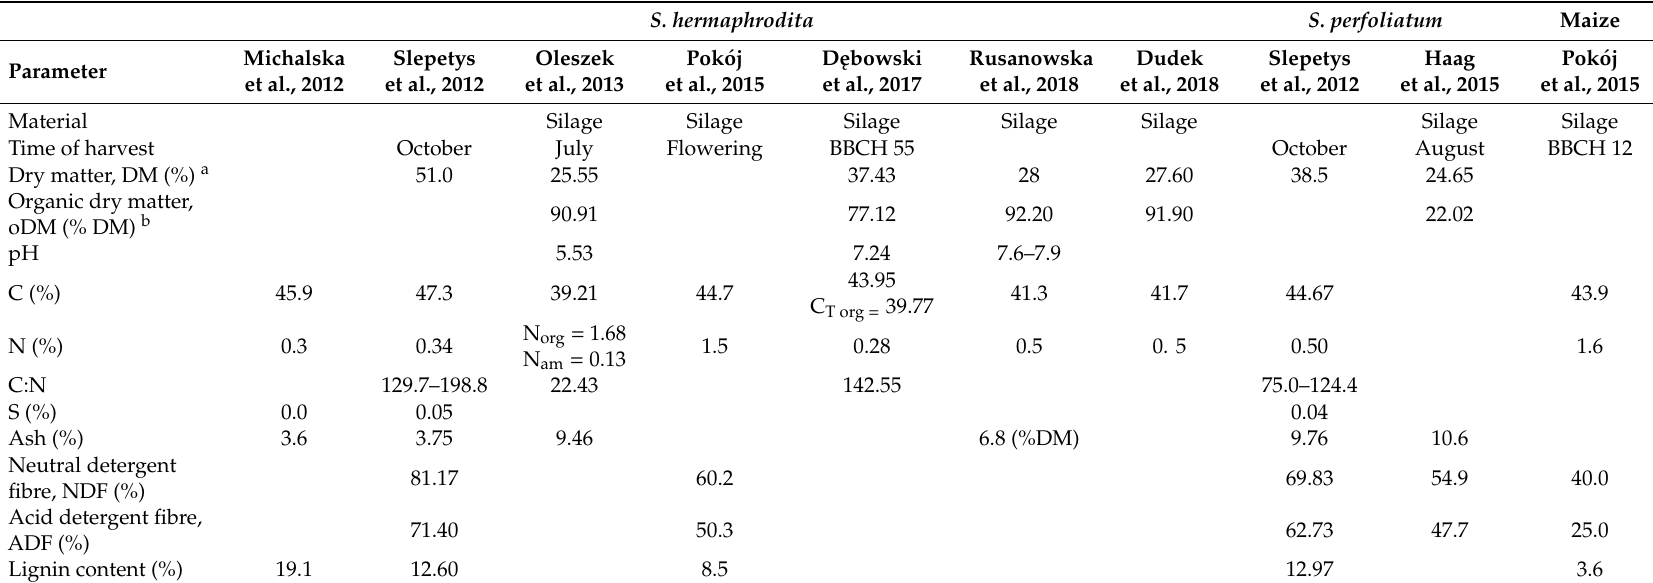
Table 7. Physicochemical properties of S. hermaphrodita and S. perfoliatum for anaerobic